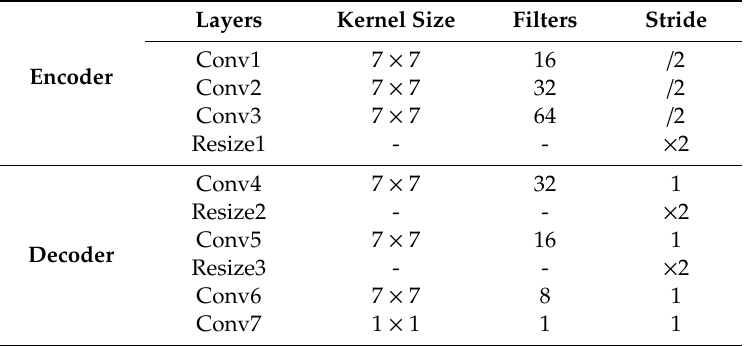
Table 1. Architecture of the utilized neural segmentation